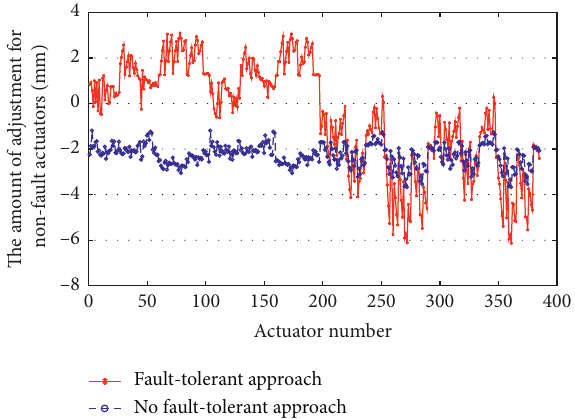
Figure 11: Nonfault actuators’ stroke at 70deg